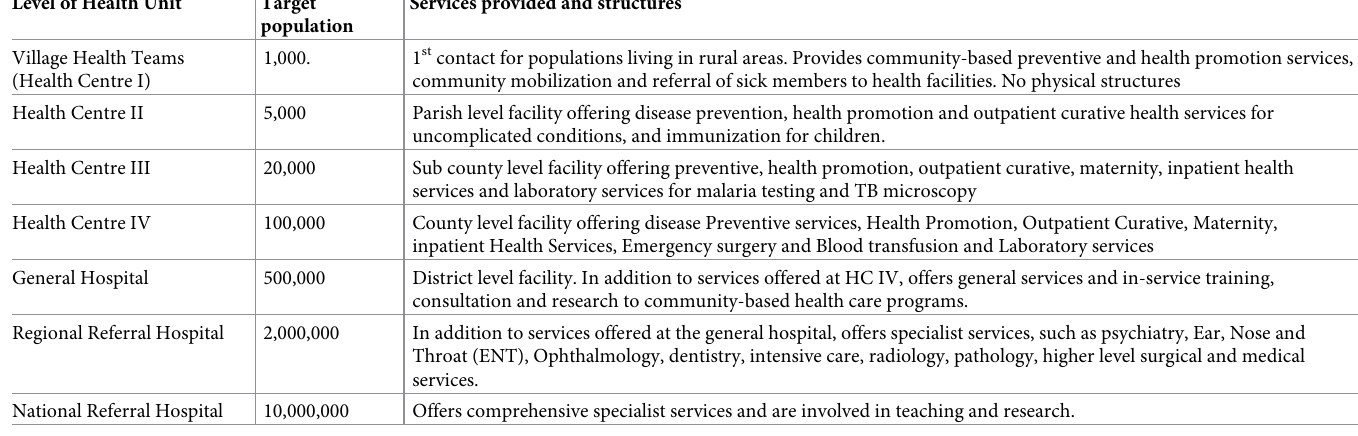
Table 1. The health facility classification in